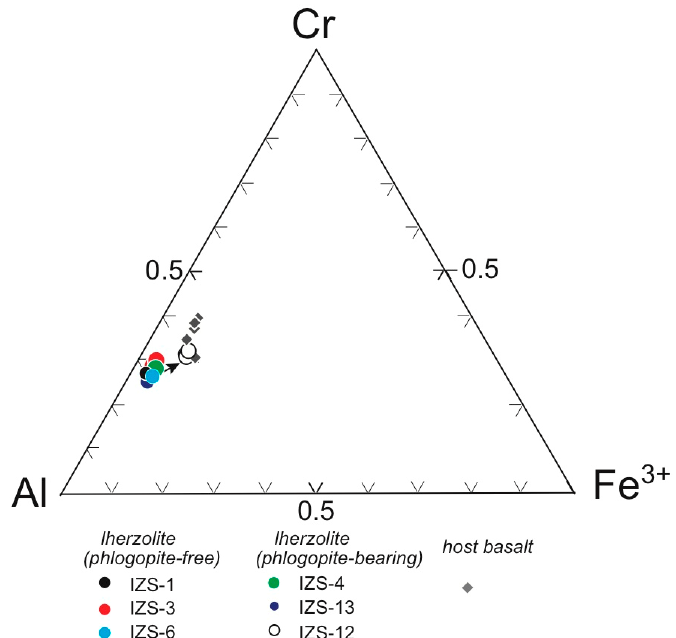
Figure 7. Trivalent cation relations of chromian spinel. Note that the chromian spinel in the lherzolite containing phlogopite veinlets (Figure 3f) is similar to that in the host basalt (inclusions in olivine phenocrysts). The arrow indicates a possible metasomatic trend.